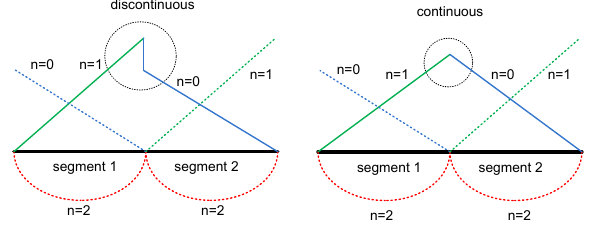
Figure 6: Two types basis functions (i) discontinuous (ii)